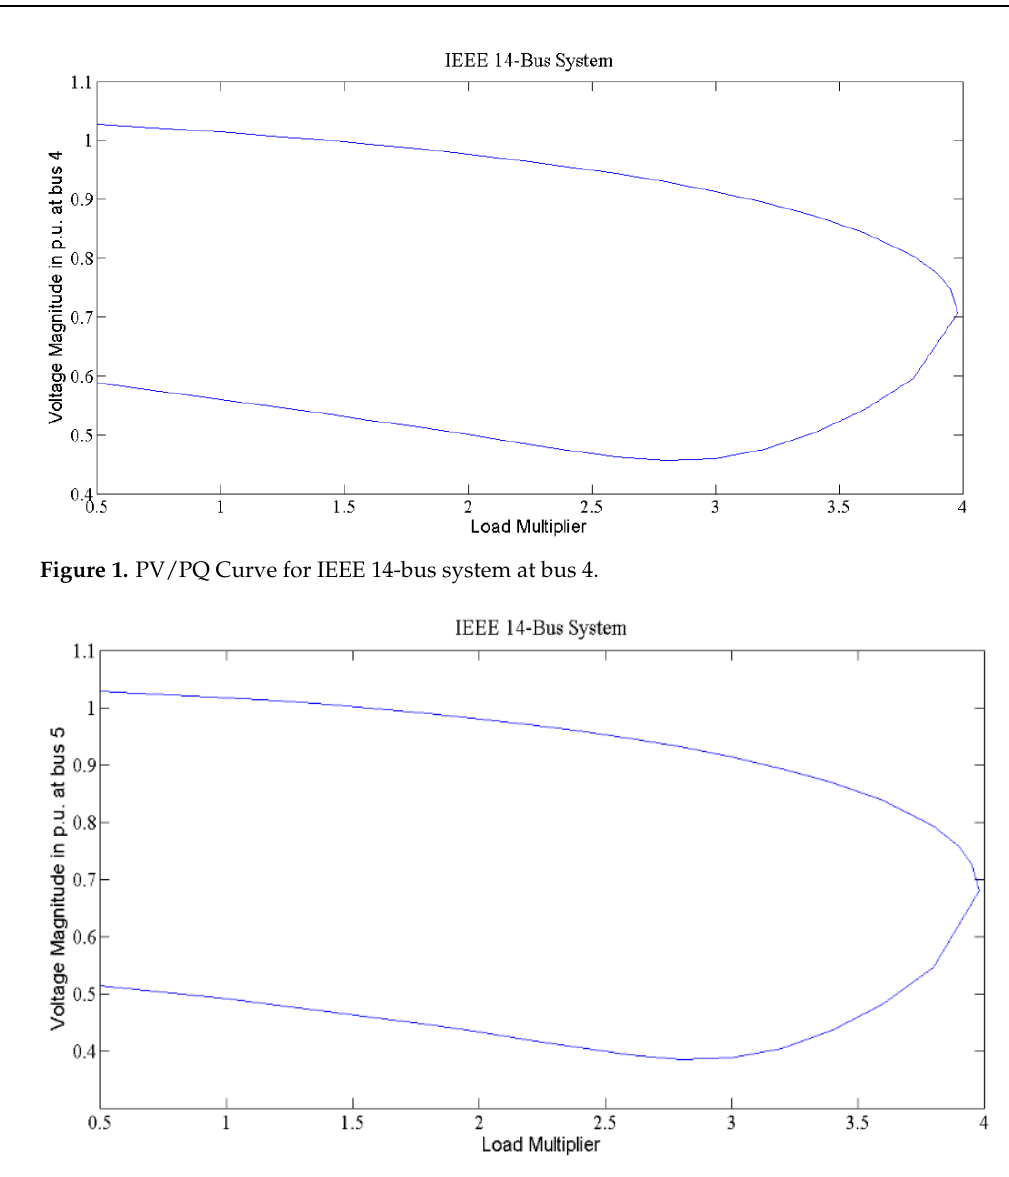
Figure 2. PV/PQ Curve for IEEE 14-bus system at bus 5.